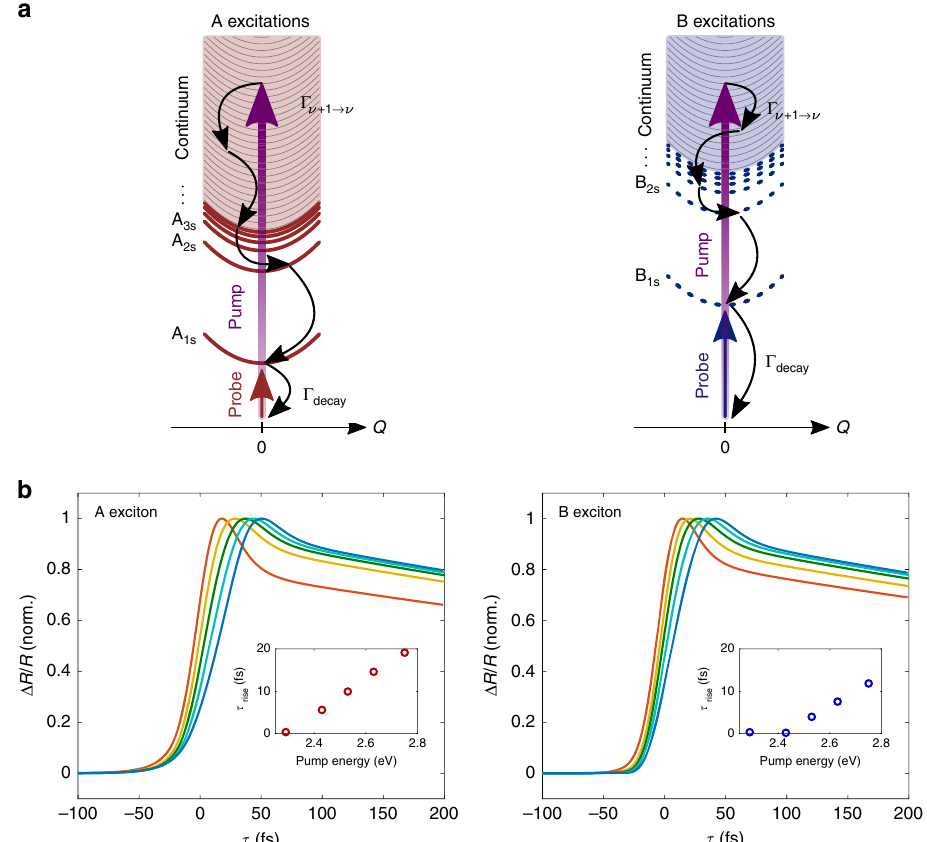
Fig. 3 Simulation of the exciton formation process. a Schematic illustration of the relaxation model in the exciton picture where Q denotes the exciton center-of-mass wave vector. After optical excitation of continuum states with the pump pulse, the sample is probed at the A 1 s (left) and B 1 s (right) exciton resonance energy. The measured signal exhibits contributions originating from instantaneous coherent polarizations as well as incoherent exciton densities, which are formed in the continuum and relax down to the energetically lowest 1s states (relaxation rate Γ ν + 1 → ν ). Finally, the exciton density associated with the lowest 1s states decays slowly with a rate Γ decay . b Calculated Δ R/R signal at the A 1 s (left) and B 1 s (right) exciton resonance energy for varying pump photon energies. All the calculated traces are normalized to the maximum value. The insets report the pump photon energy dependence of τ rise of the calculated Δ R/R traces. The calculated τ rise values are estimated by fi tting the traces with a rising exponential convoluted with a Gaussian pro fi le accounting for the fi nite temporal duration of the pump and probe pulses used in the calculation (i.e., respectively 20 fs and 15 fs). The B exciton traces exhibit, as expected, a slightly shorter rise time. This difference between the timescales is well below the temporal resolution of the pump-probe experiment and cannot be resolved by the measurements. Similar experimental τ rise for the A 1 s and B 1 s excitonic resonances might also be due to the mixing of excitonic states due to intra and intervalley exchange coupling mechanism 22 .